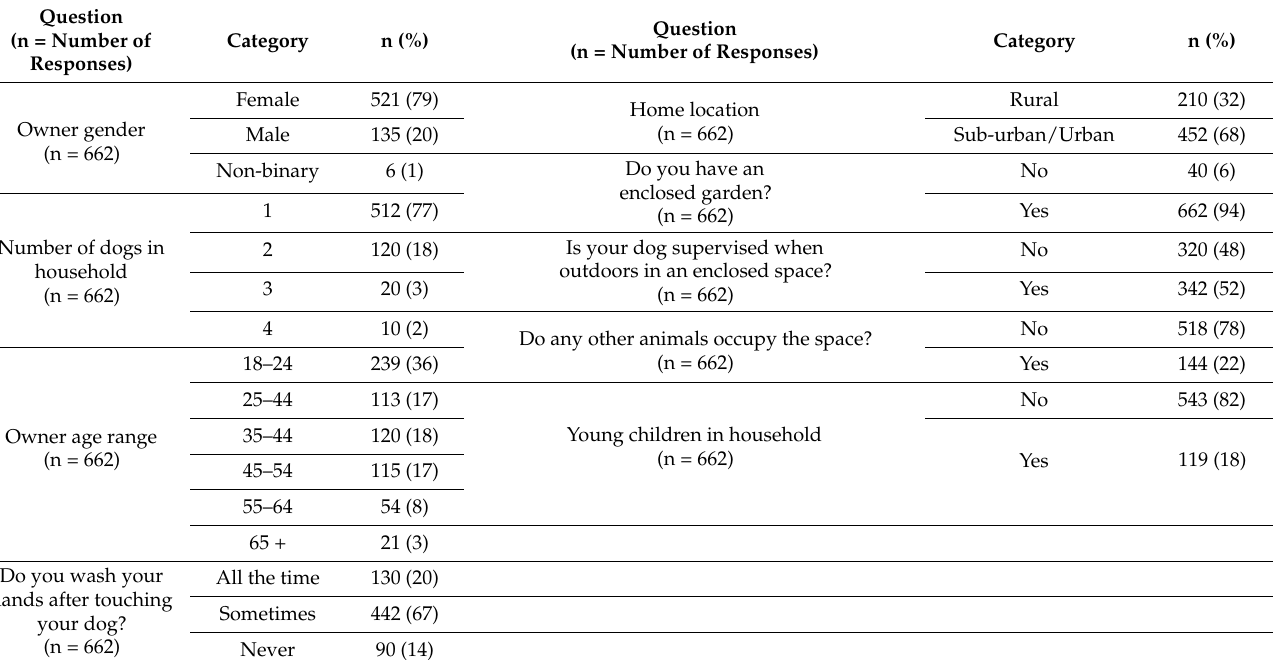
Table 1. Responses of dog owners to the questions regarding their